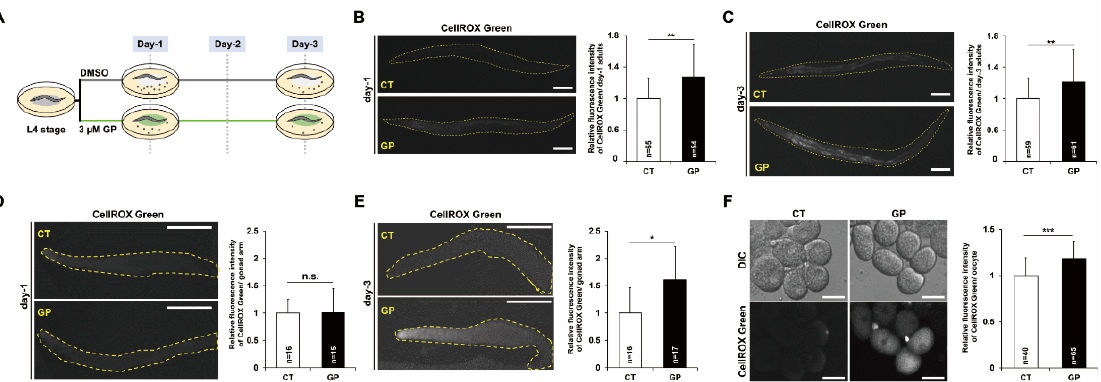
Figure 1. Gliadin peptide (GP) intake increases mitochondrial ROS production (mtROS) in adult C. elegans . ( A ) Experimental scheme of GP treatment. The synchronized wild-type N2 worms at L4 stage were incubated on NGM plates containing 0 (DMSO) or 3 µM of GP at 20 °C, and then worms were examined at day 1 or day 3 post L4 stage. ( B – F ) Comparison of the mtROS levels in worms ( B , C ), in the dissected gonad ( D , E ), or in the oocytes ( F ) treated with 0 (CT) and 3 µM of GP at the L4 stage for 1 day ( B , D ) or 3 days ( C , E , F ) using CellROX ® Green staining. The dashed line indicates the outline of the whole body ( B , C ) or distal gonad ( D , E ). Scale bars are 50 µm ( B – E ) or 20 µm ( F ). Error bars represent SD. n.s.: not significant, * p < 0.05, ** p < 0.005, *** p < 0.001 (Student’s t -test).